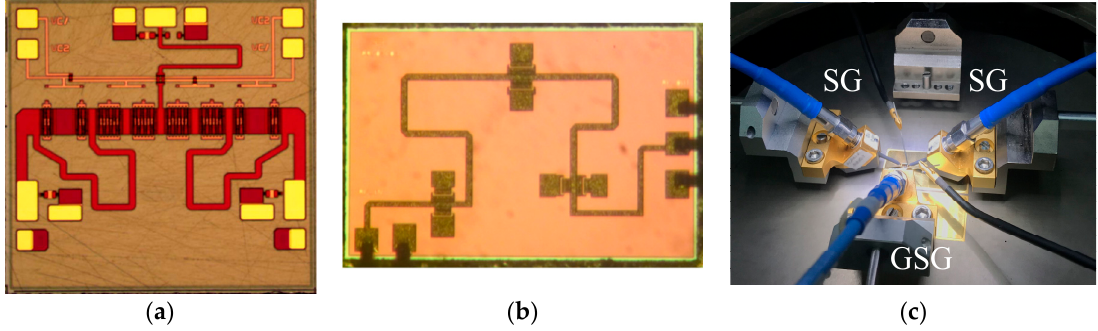
Figure 11. Photos of the switch and limiter chips and the test system. ( a ) The photo of the switch chip; ( b ) The photo of the limiter chip; ( c ) The photo of the test system.